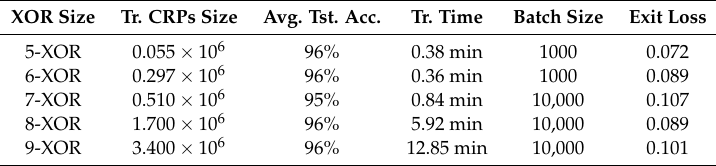
Table 4. Prediction rate and timing of our attacking method using 28-nm test chips